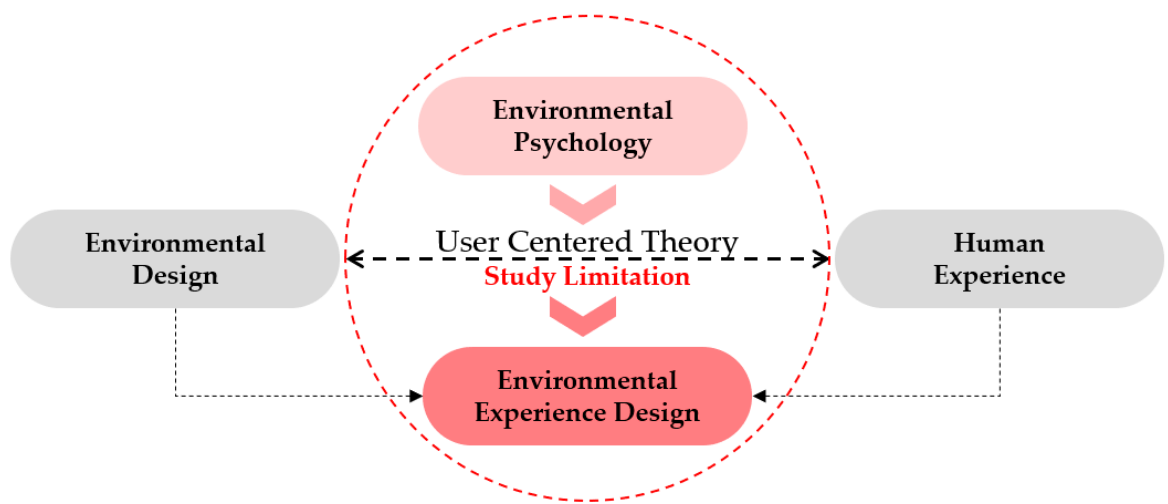
Figure 11. Research gap and future experience design direction. Modified from Source: [4,43].